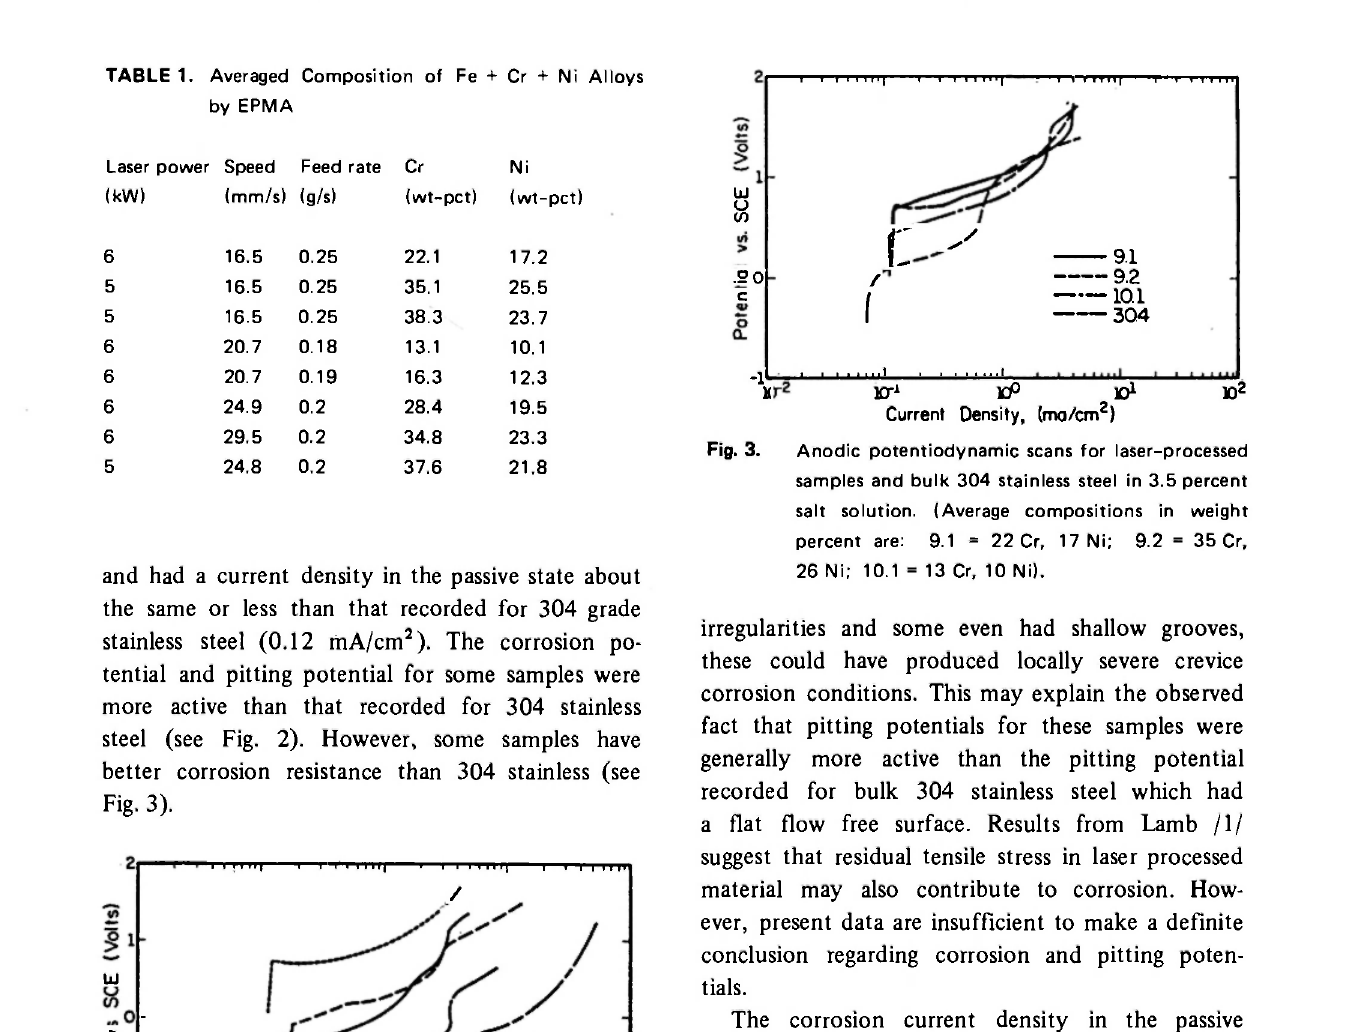
Fig. 2. Anodic potentiodynamic scans for laser-processed samples and bulk 304 stainless steel in 3.5 percent salt solution. (Average compositions in weight percent are: 10.2 = 16 Cr, 12 Ni; 10.3 = 28 Cr,